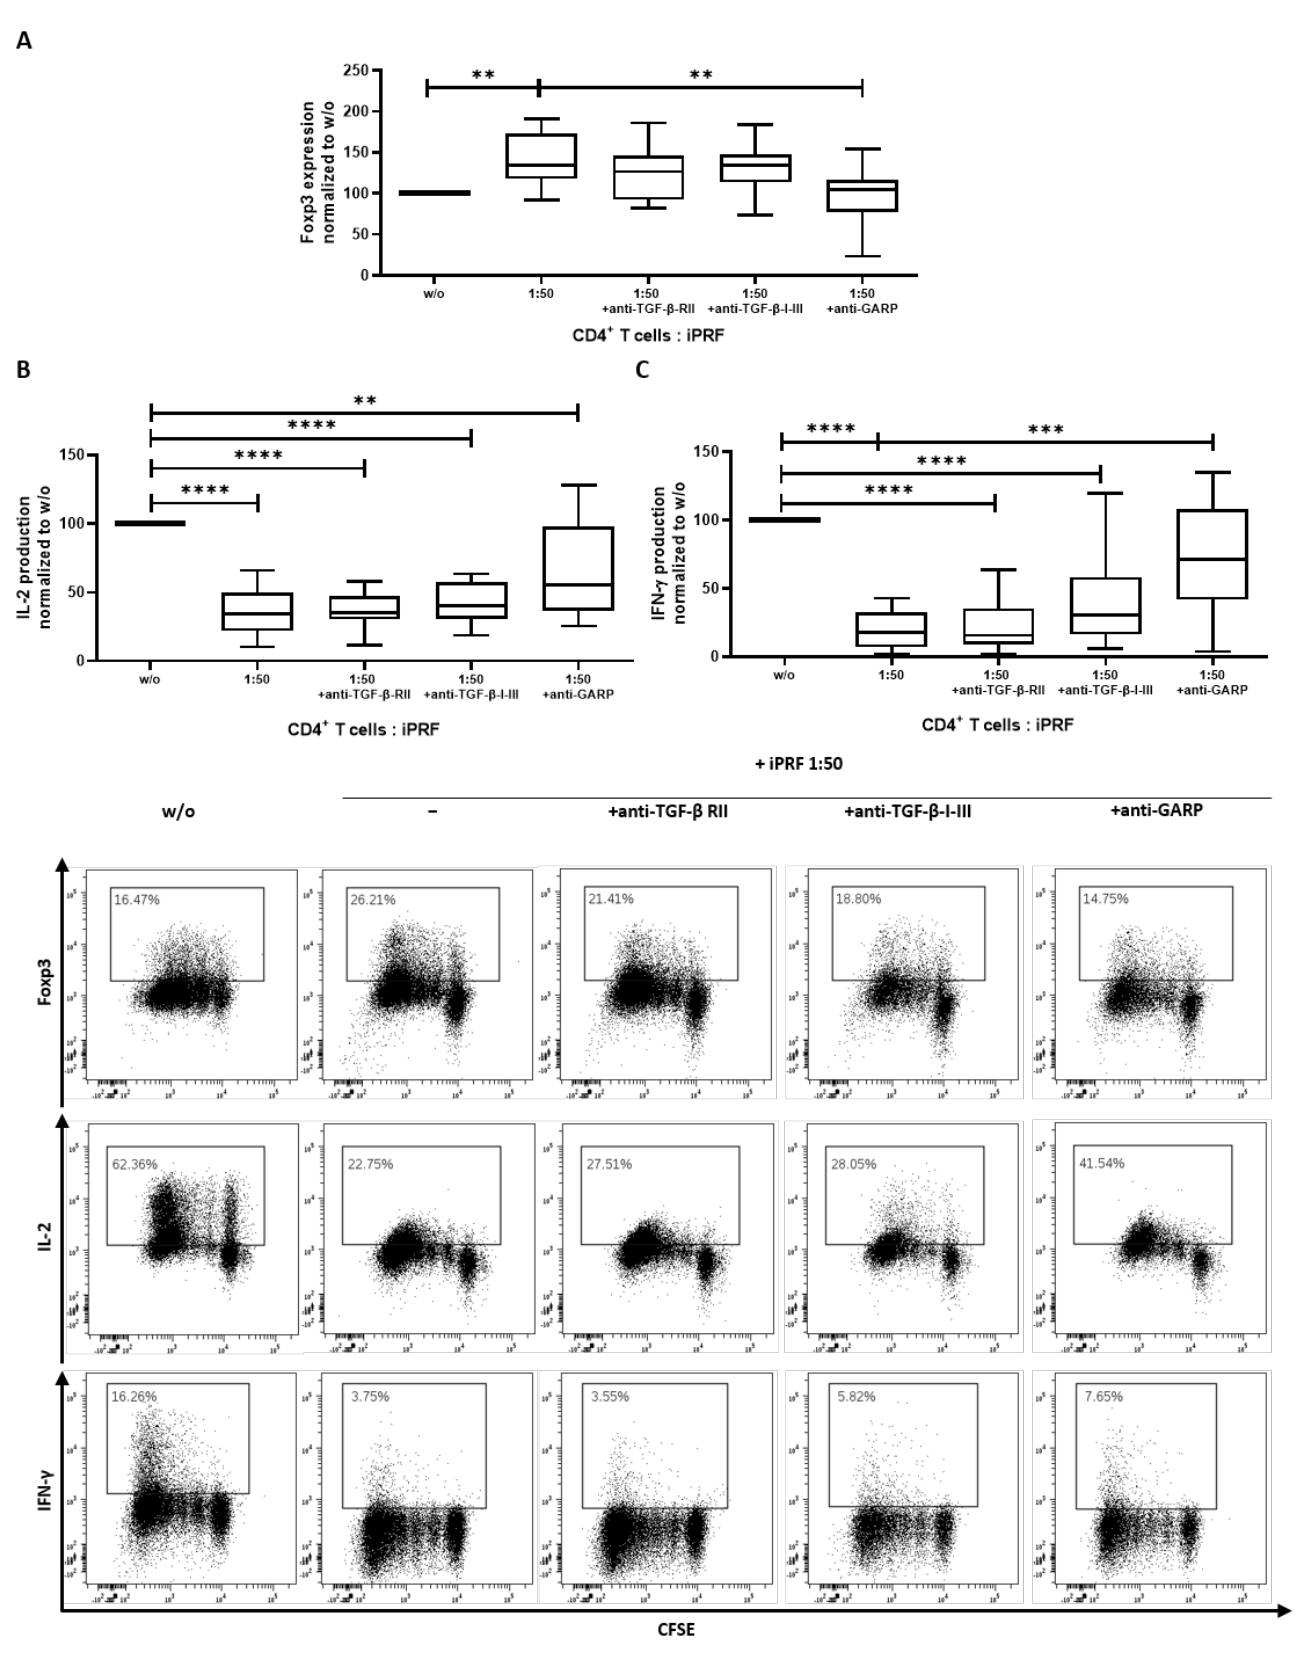
Figure 3. Liquid platelet rich fibrin (iPRF) induces a regulatory phenotype in CD4 + T cells. CD4 + T cells and iPRF were cocultured at a ratio of 1 to 50 and treated with either 10 µg/mL anti-TGF-ß receptor II (anti-TGF- β -RII) antibody (Ab), 10 µg/mL anti-TGF- β -1-III Ab, or 10 µg/mL anti-GARP